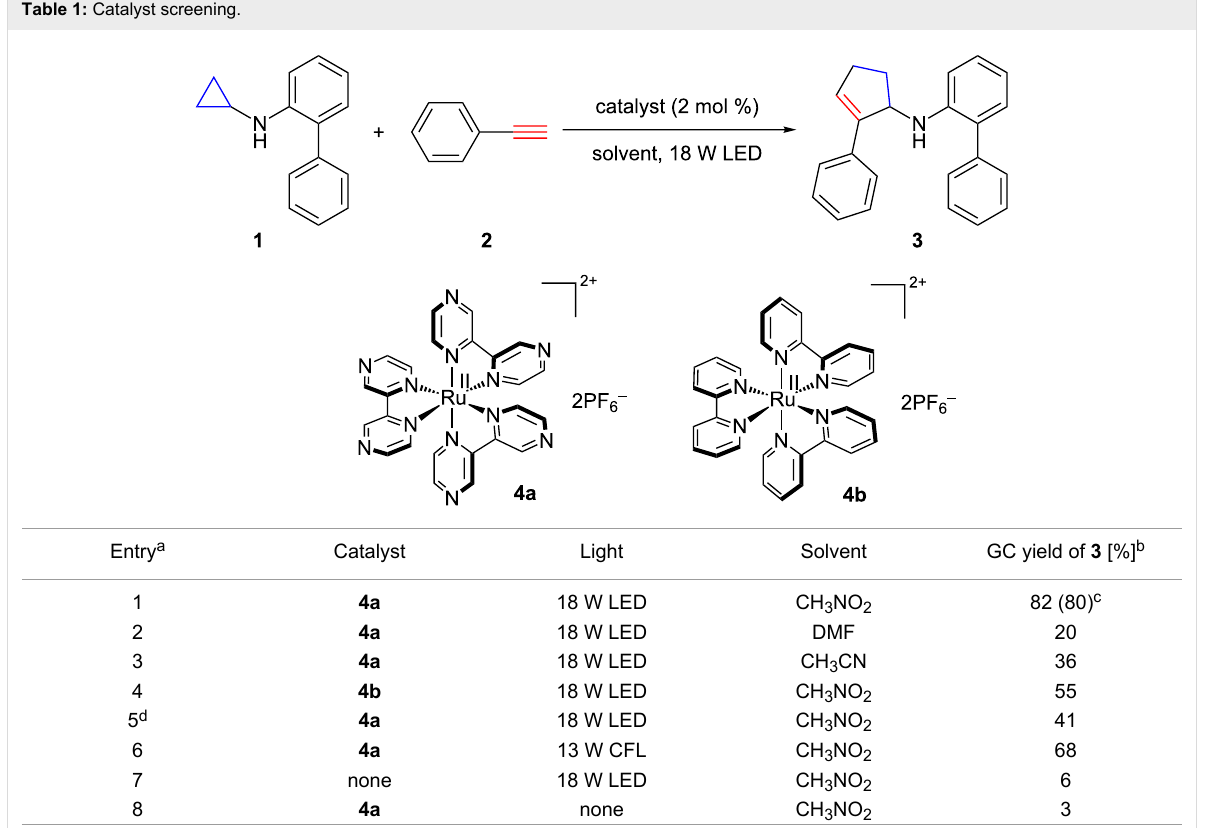
Table 1: Catalyst